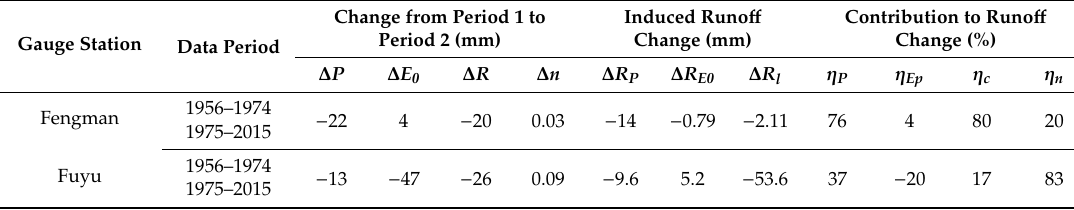
Table 4. Attribution analysis for the Fengman Reservoir and Fuyu Station in SSRB.